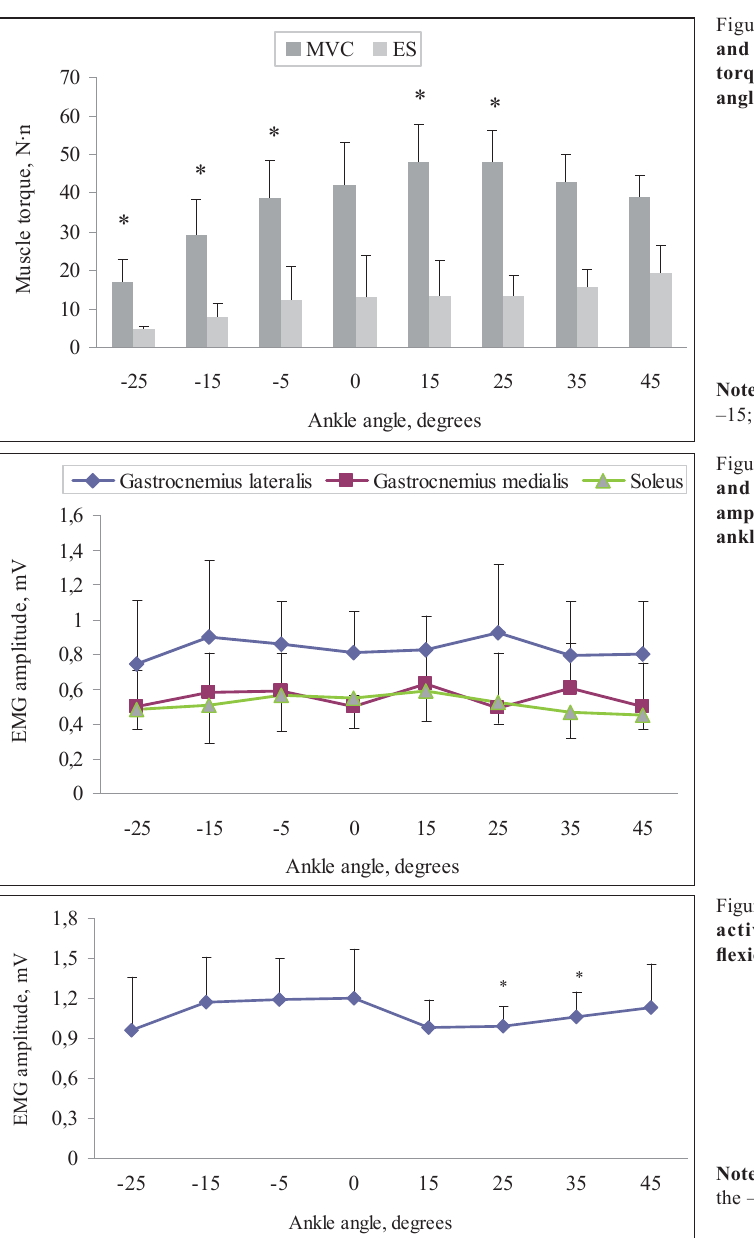
Note. * – p < 0.05, the difference between the 0° and the –25; –15; –5; 15; 25; 35; 45°